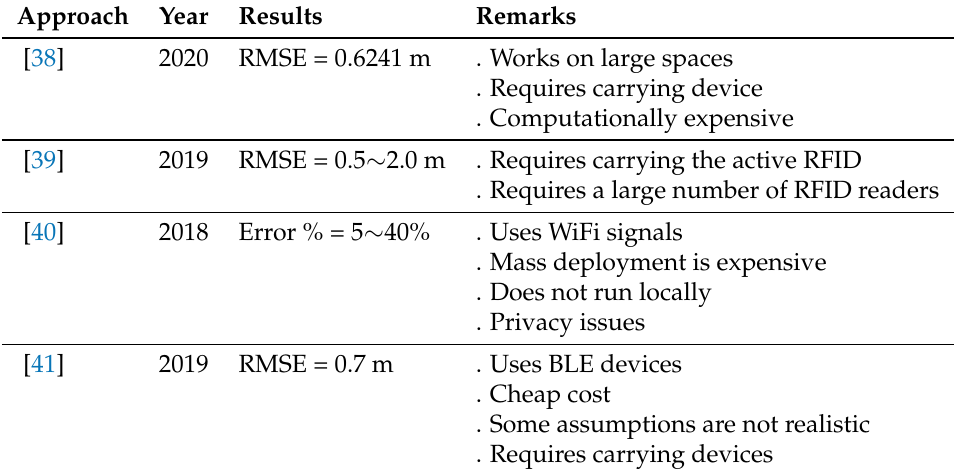
Table 16. Comparison with existing methods for indoor